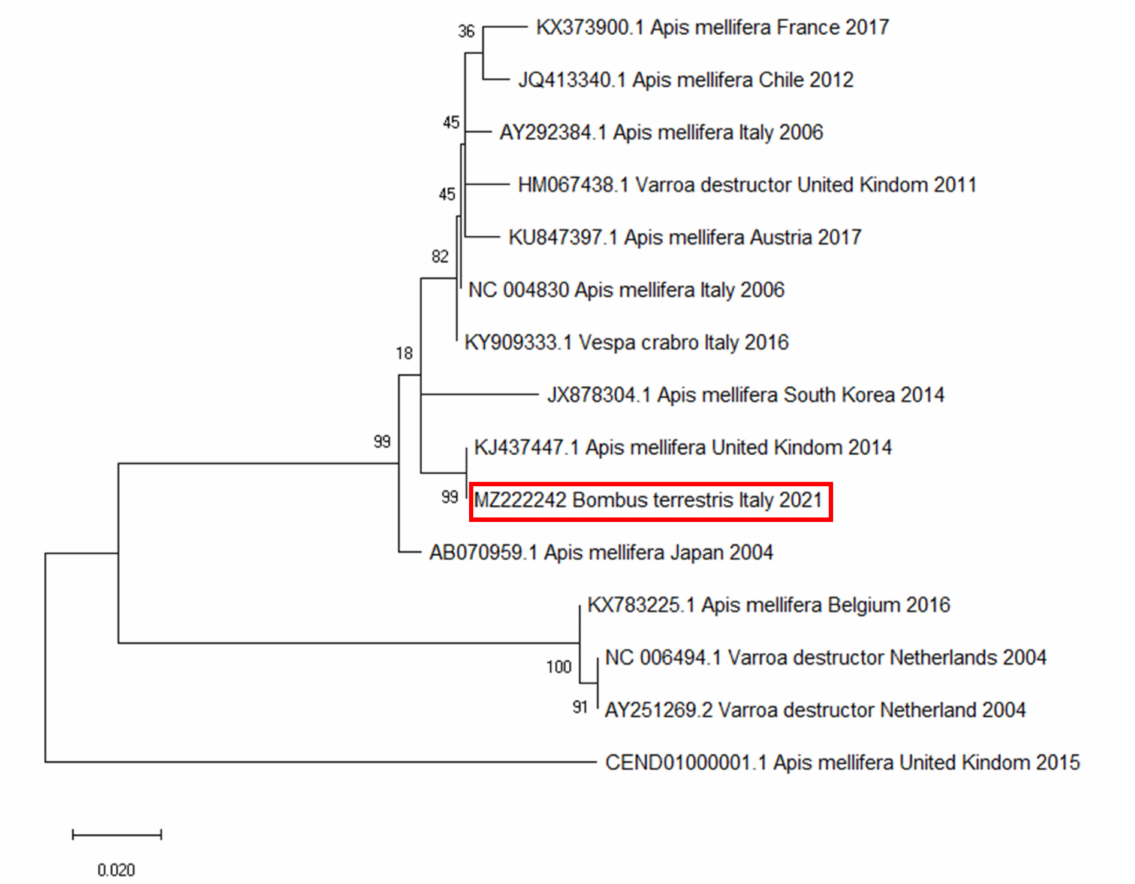
Figure 5. Molecular phylogenetic analysis for RNA-dependent RNA polymerase of deformed wing virus (DWV) by maximum likelihood method. The evolutionary history was inferred using the maximum likelihood method based on the Tamura–Nei model. The branch lengths of the tree measured the number of substitutions per site. The analysis involved 28 nucleotide sequences. There were 255 positions in the final dataset. Accession number, host, state, and year of available GenBank DWV sequences are shown. DWV sequence accession numbers are reported and associated with year and site of origin. The DWV sequence obtained from the tested B. terrestris samples is highlighted by a red